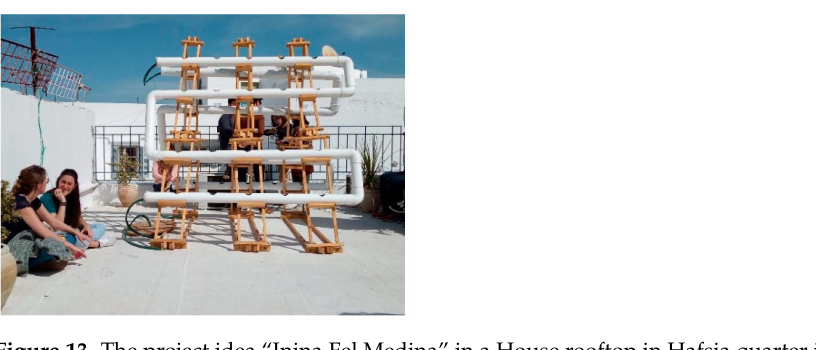
Figure 12. The project idea “Jnina Fel Medina” in a House rooftop in Hafsia quarter in the Medina of Tunis (data source: Faika Bejaoui (one of the project initiators) photography).